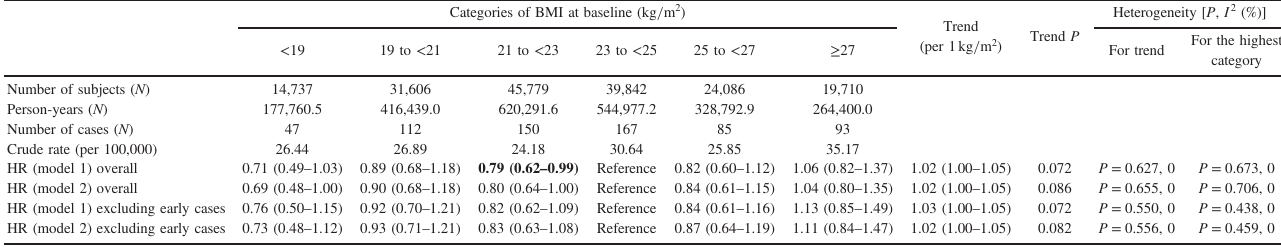
BMI, body mass index. Model 1 adjusted for age and area (within each study for JPHC and JACC). Model 2 adjusted for age, area, smoking (pack-years [PY] = 0, 0 < PY ≤ 20, >20, or unknown), drinking (never, <1 week = day, current <23g = day, ≥ 23g = day, or unknown), and history of diabetes (yes, no, or unknown). HRs values in bold show statistical signi fi cance. Table 5. Hazard ratios (HR) and 95% con fi dence intervals (CI) for pancreatic cancer risk according to category of BMI during early adulthood among females